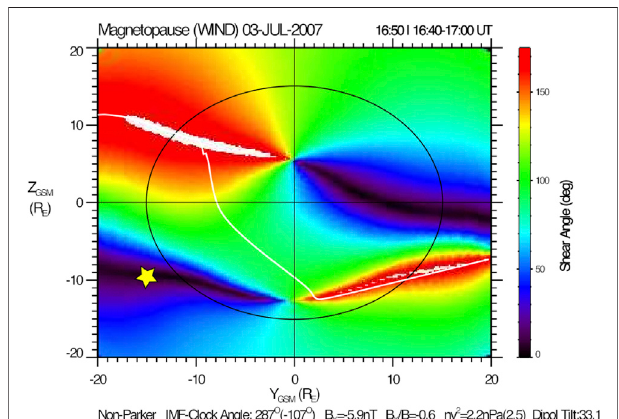
FIGURE 10 | The magnetopause shear angle for IMF values B Z < 0, B Y < 0 as seen from the Sun. Red areas represent magnetopause regions where the geomagnetic fi eld and IMF are antiparallel within 150 ° – 180 ° . White regions embedded in the red regions represent the line of maximum magnetic shear angles which are thought to be the most likely location for reconnection to occur. The black circle represents the location of the x (cid:1) 0 plane. Earth ’ s dayside and nightside magnetopause are shown inside and outside of the black circle, respectively. The yellow star marks the location of Cluster SC 1 (X GSM ≈ − 9.5 R E , Y GSM ≈ − 15 R E , Z GSM ≈ − 9.5 R E